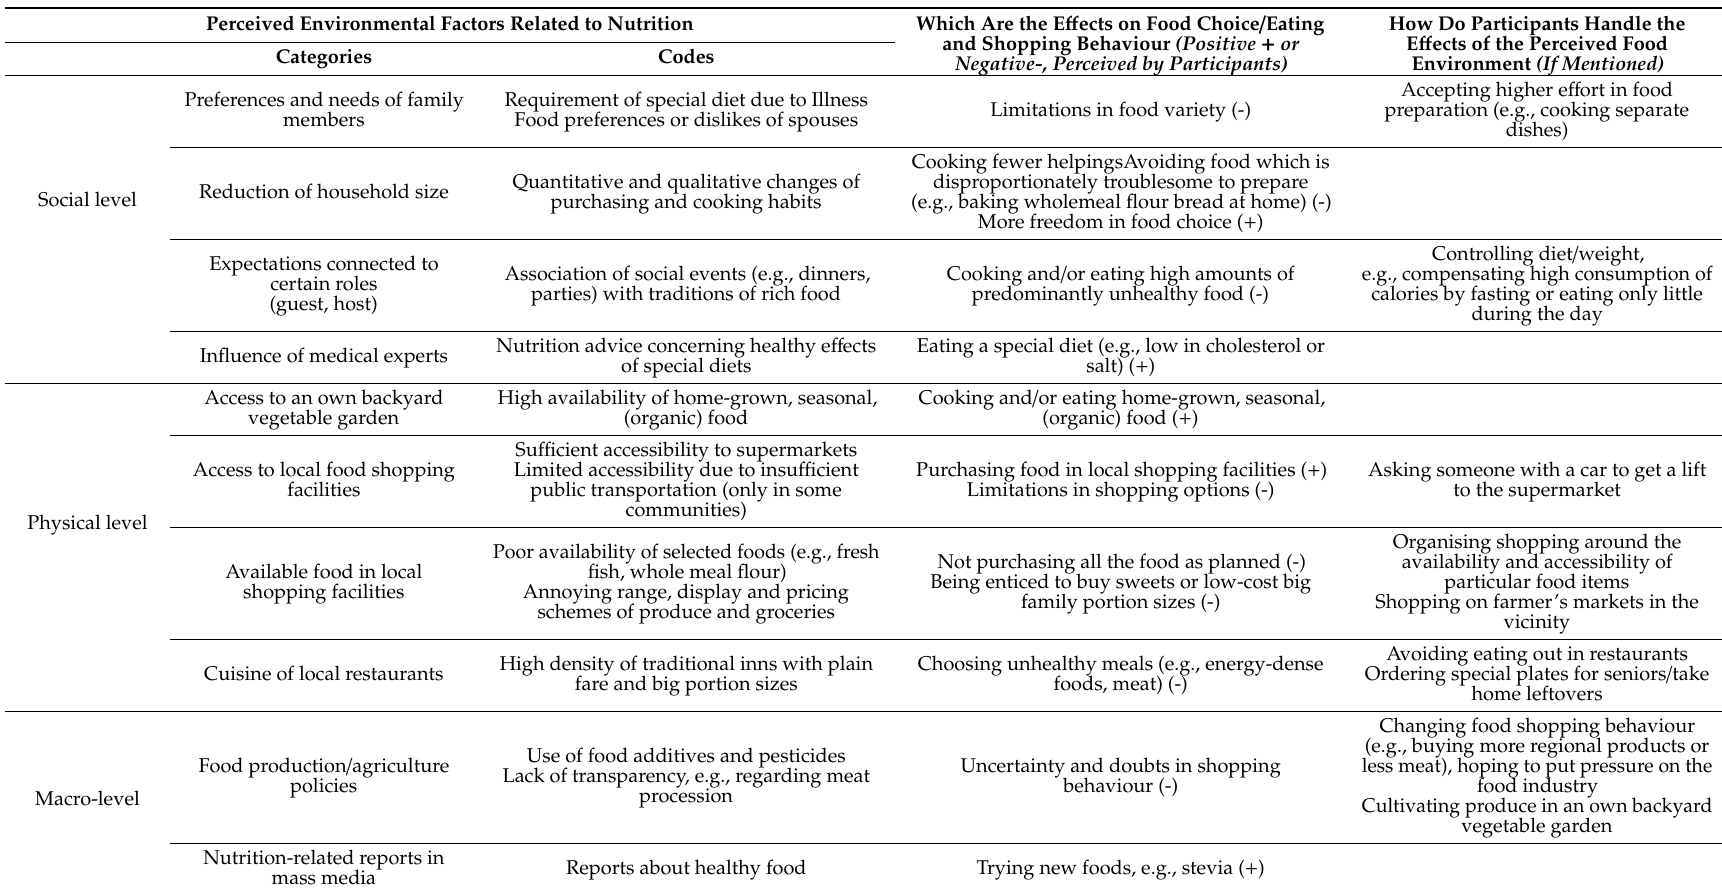
Table 2. The perceived food environment of older citizens in rural